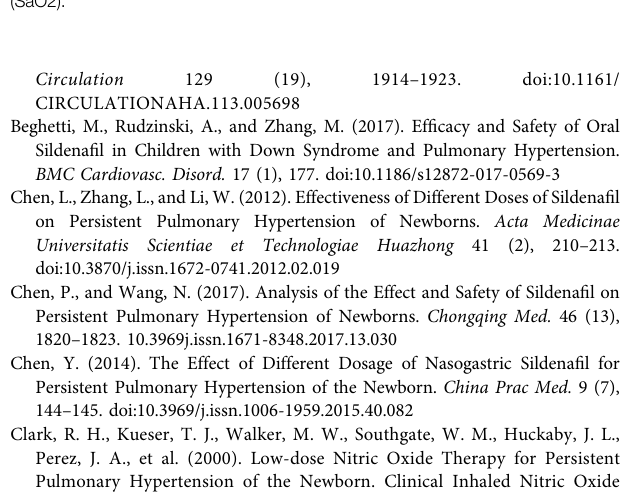
Supplementary Figure 1 | Network forest plot of PASP Pulmonary Artery Systolic Pressure (PASP). Supplementary Figure 2 | Network forest plot of SBP Systolic Blood Pressure (SBP). Supplementary Figure 3 | Network forest plot of PaCO2 Partial Pressure of Carbon Dioxide (PaCO2). Supplementary Figure 4 | Network forest plot of PaO2 Partial Pressure of Oxygen (PaO2). Supplementary Figure 5 | Network forest plot of SaO2 Arterial Oxygen Saturation